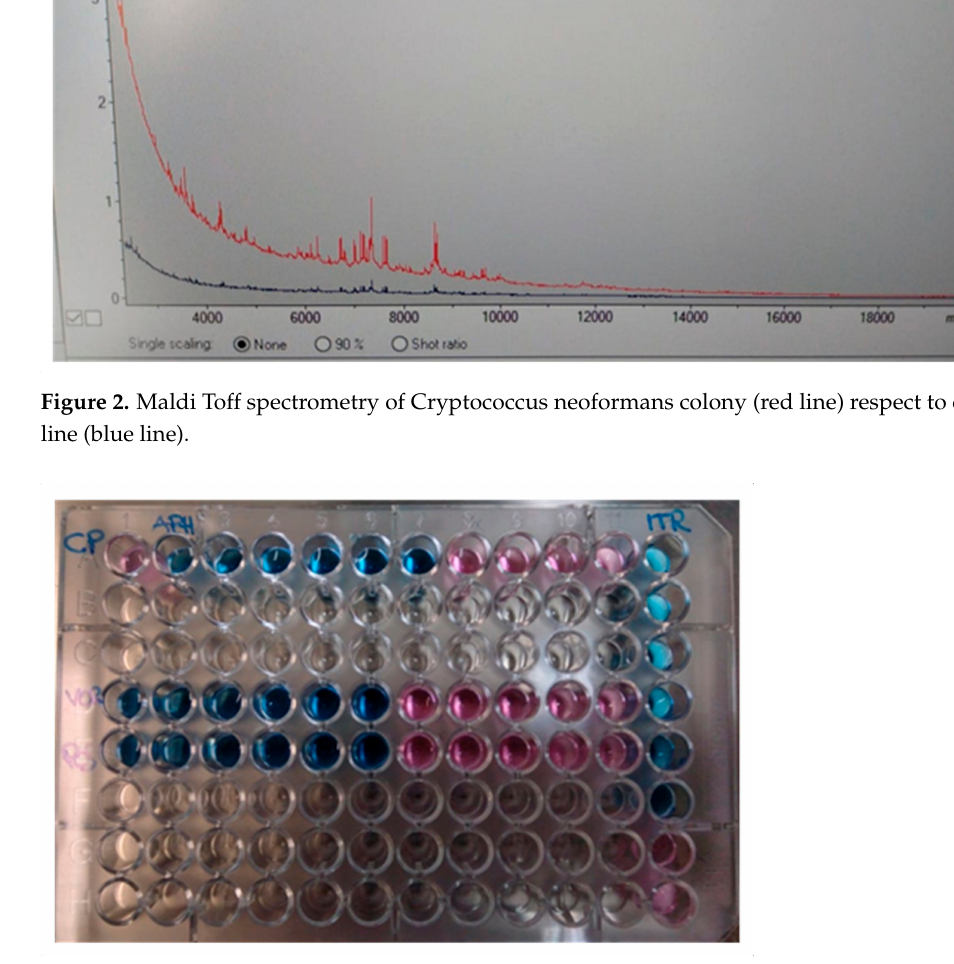
Figure 3. Broth microdilution plates of blood cultures. In blue: sensible concentration. In red: resistant